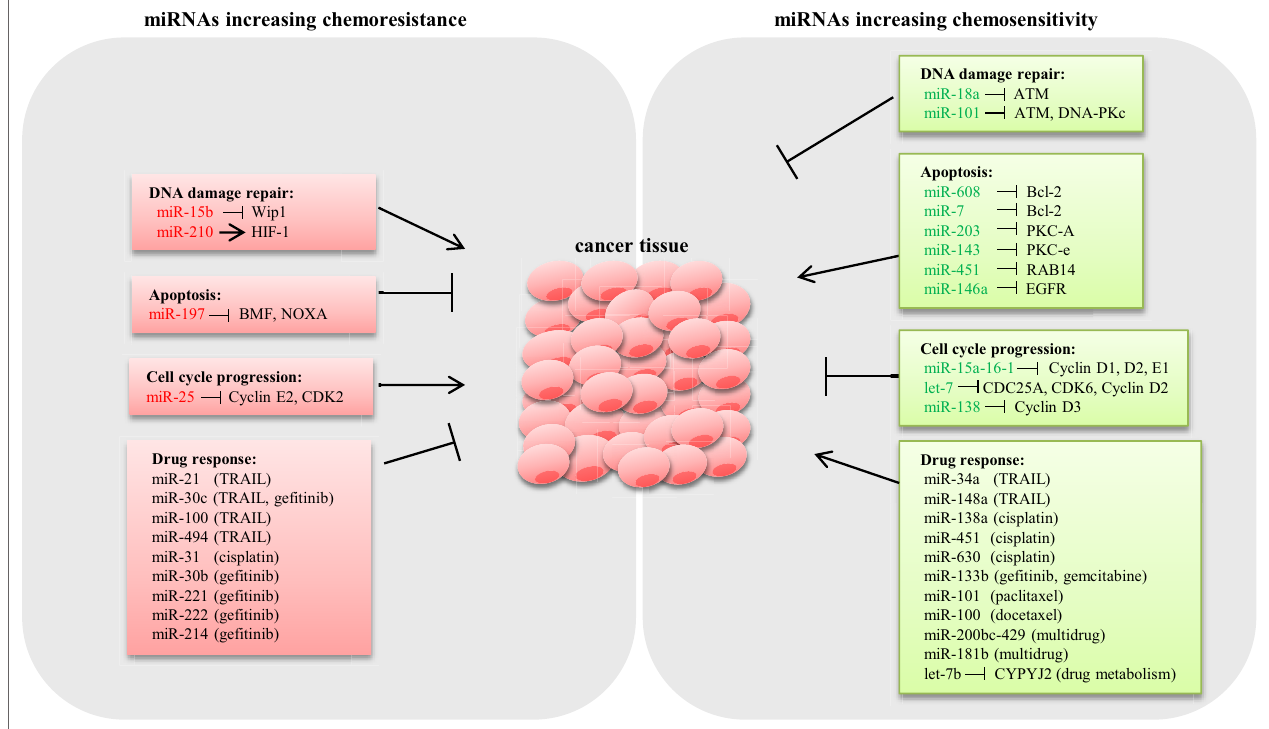
FiGURe 1 | Schematic representation of miRnAs involved in lung cancer chemoresistance . Several miRNAs have shown to modulate the expression of key genes involved in chemoresistance mechanisms in lung cancer. miRNAs conferring chemoresistance are shown in red, and miRNAs responsible for enhancing drug response are shown in